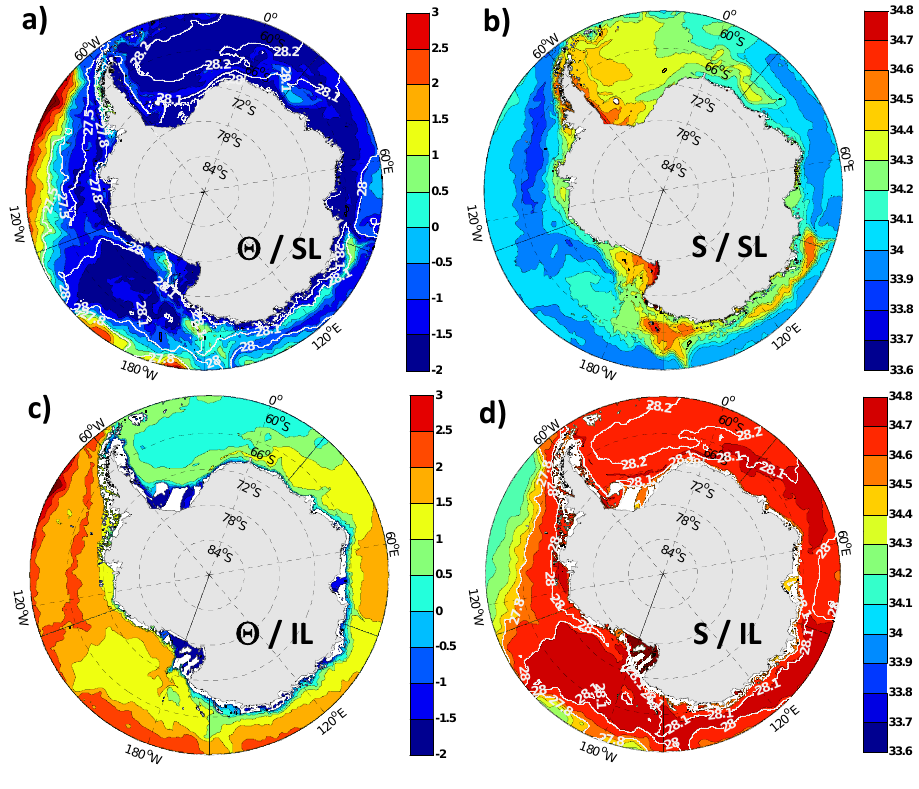
Fig. 5. OCCAM average field at ( a and b ) shelf/surface layer (SL) and ( c and d ) intermediate layer (IL) of (left) potential temperature ( θ) in ◦ C and (right) salinity ( S ). Neutral density surfaces (kg m − 3 ) are plotted in (a) and (d)